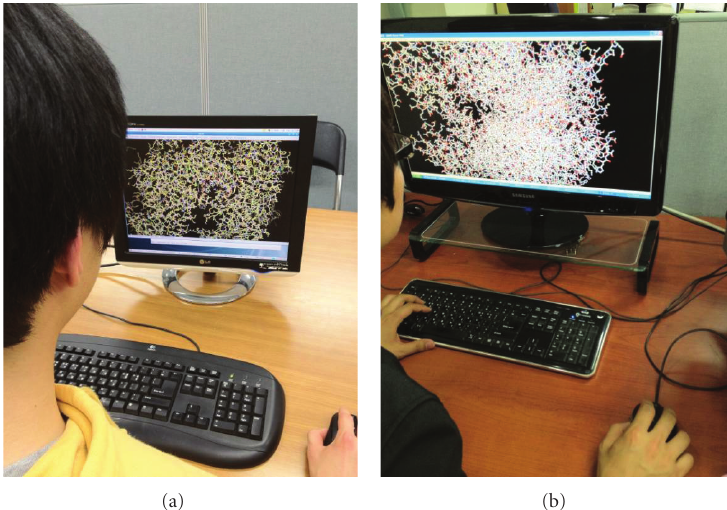
Figure 6: Collaborative molecular modeling: (a) a user is using Co-Coot; (b) another user is using VRMMS.